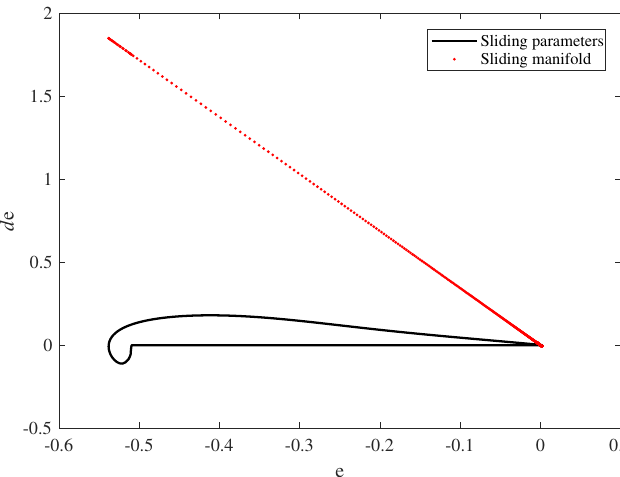
Figure 6. The plane phase diagram of e -˙ e under target speed